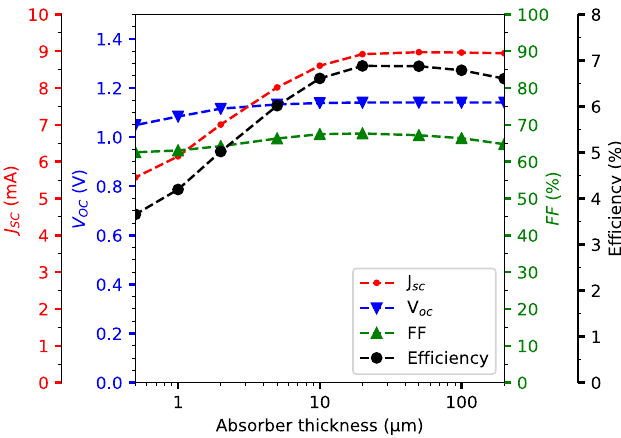
Fig. 3. Evolution of the solar cell performances with the absorber thickness ranging from 0.5 m m to 200 m m. J SC is the short cicuit current; V OC is the open circuit voltage; FF is the fi ll factor.